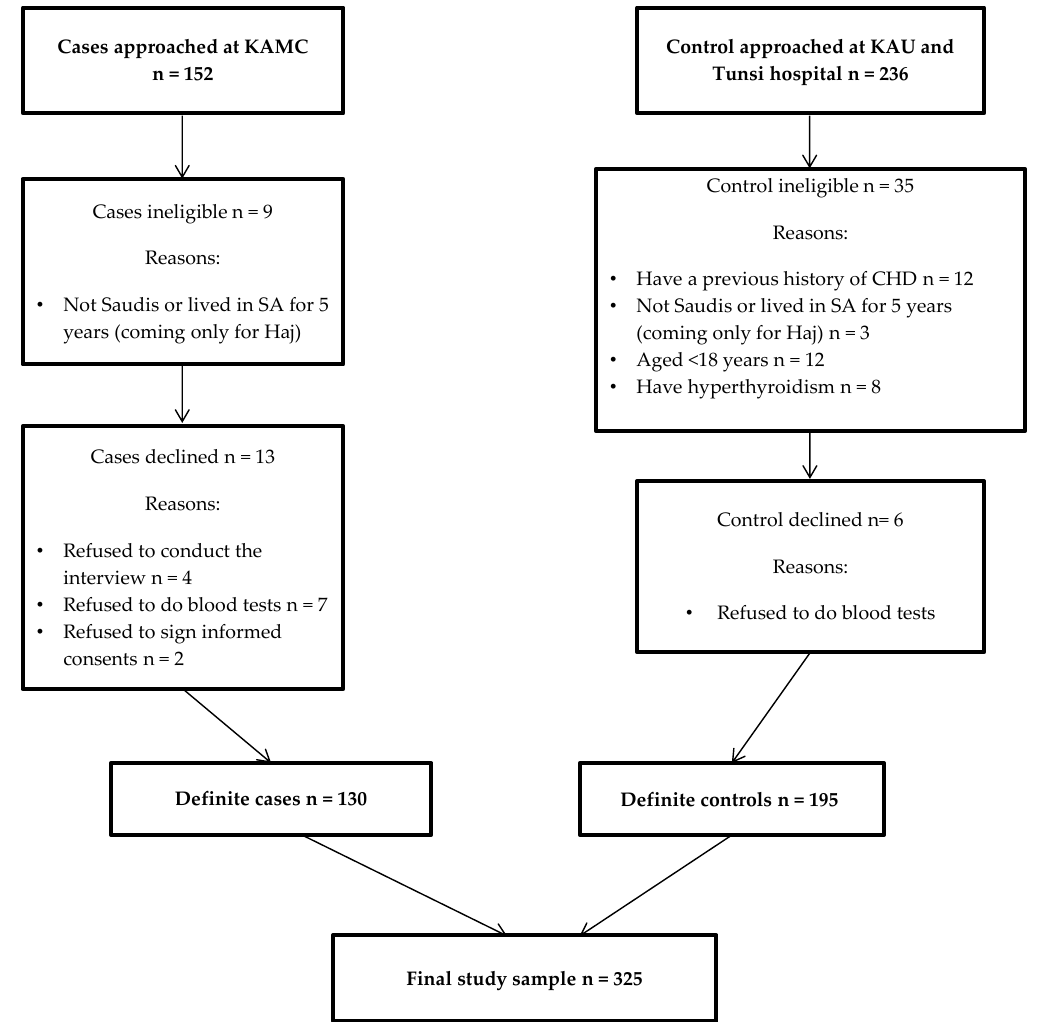
Figure 1. The subject’s recruitment process and reason for refusal to participate in the study.